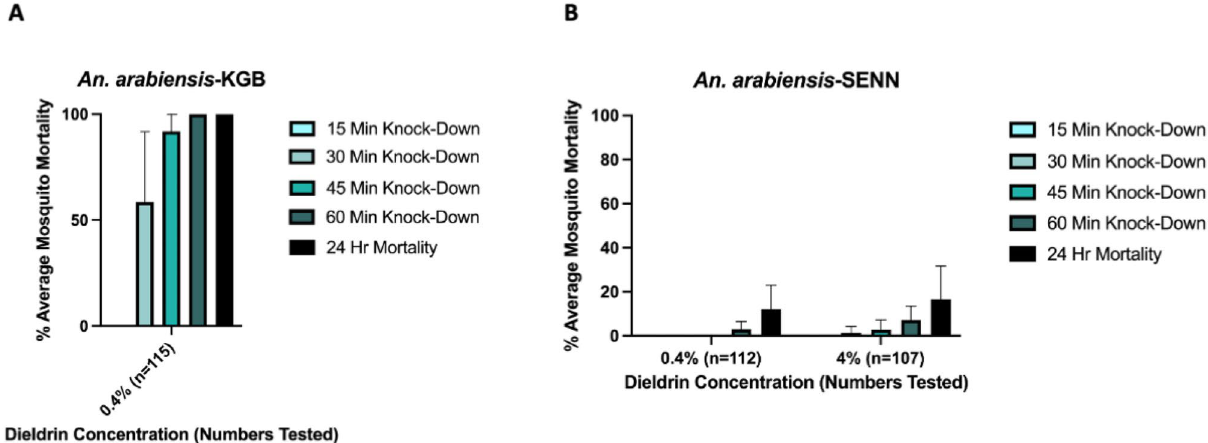
Figure 3. An. arabiensis KGB ( A ) and An. arabiensis SENN ( B ) mortality after exposure to dieldrin in WHO susceptibility tests. Error bars represent 95% confidence intervals